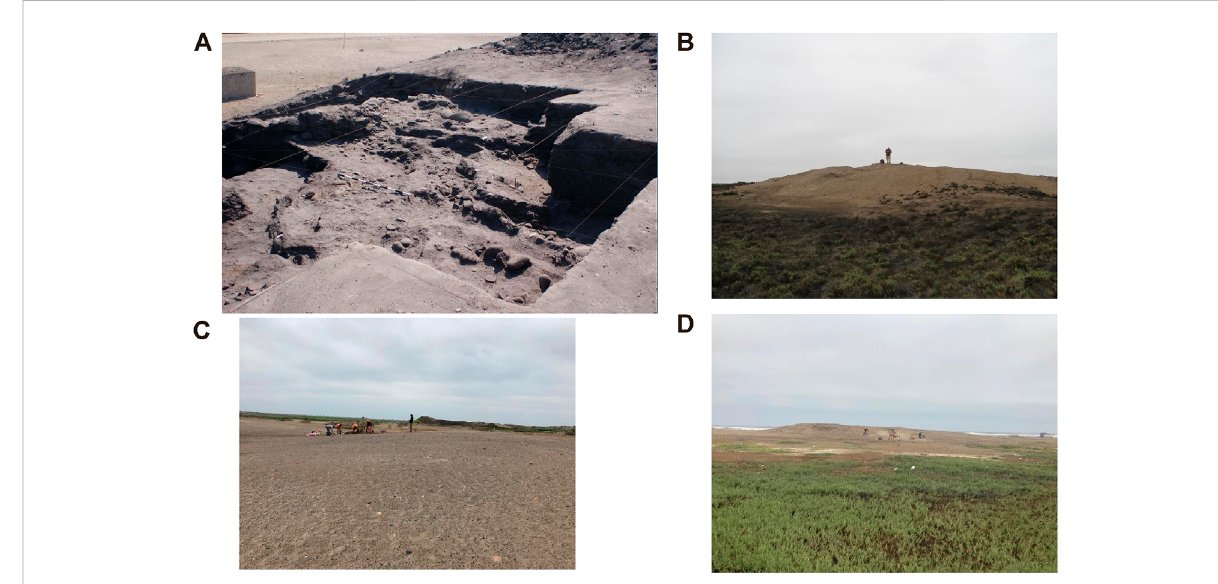
FIGURE 9 (A) Stratigraphically sequenced and superimposed oval-shaped, stone-lined Preceramic houses in Unit 16 located on the western edge of the SangamonterracenearthePaci fi cOceanandproximaltotheHuacaPrietamound; (B – D) :Domesticmoundsiteslocatedalonglittoralbeachridges and inland washes and wetlands north of the Sangamon terrace (see Figure 8). An increasing number of these sites are being destroyed by modern- day residential and agricultural expansion.